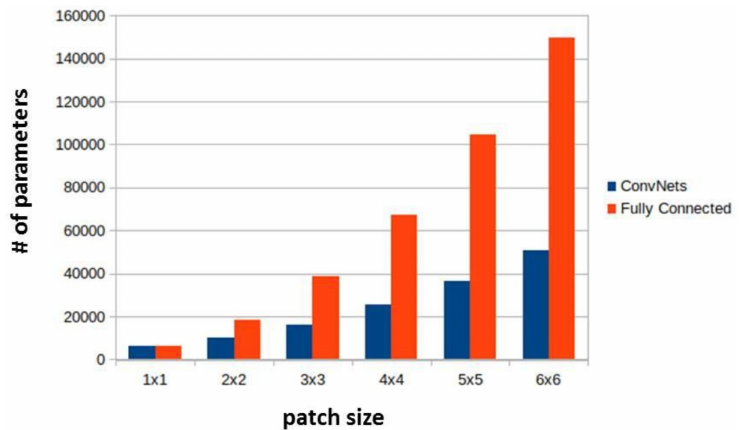
Figure 14. Bar graph of the number of parameters vs. patch